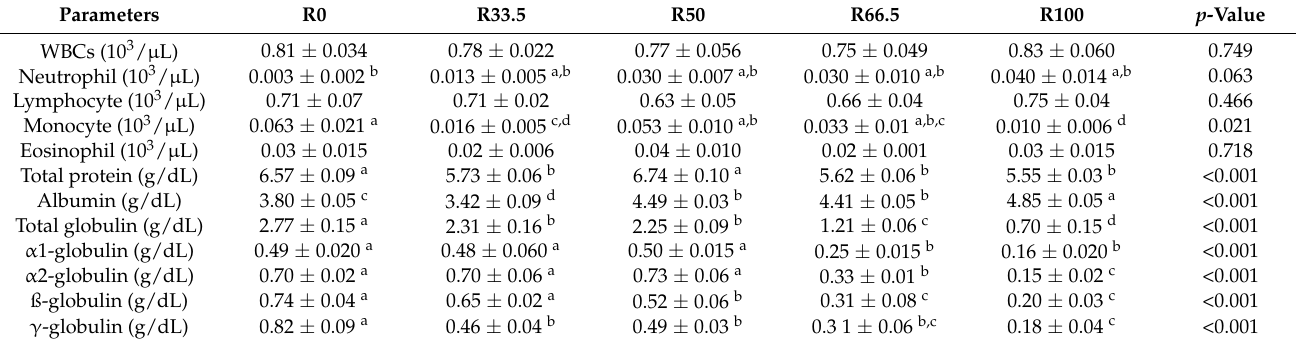
R0, R33.5, R50, R66.5 and R100: see legend of Table 1. WBCs: white blood cells. Values with different superscripts within the same row ( a , b , c , and d ) were significantly different ( p < 0.05, using one-way